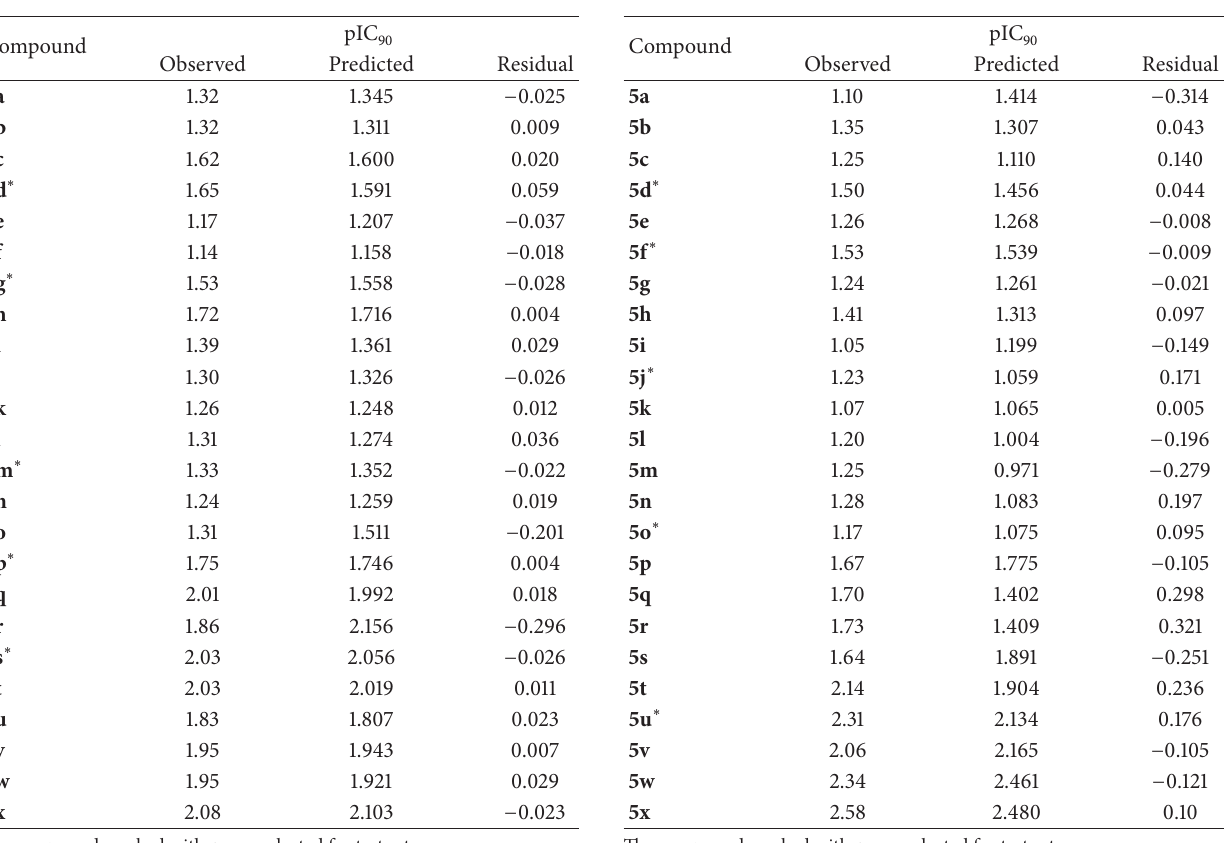
Table 4: Observed and predicted activities for training and test set of Oryza sativa CoMFA model.